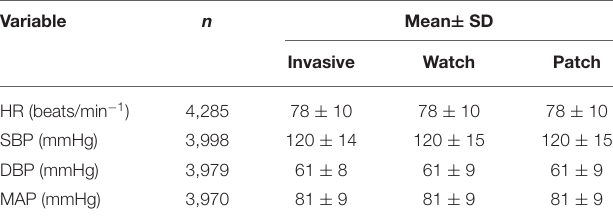
TABLE 2 | Number of comparisons for each variable and mean ± SD values for each variable per device.